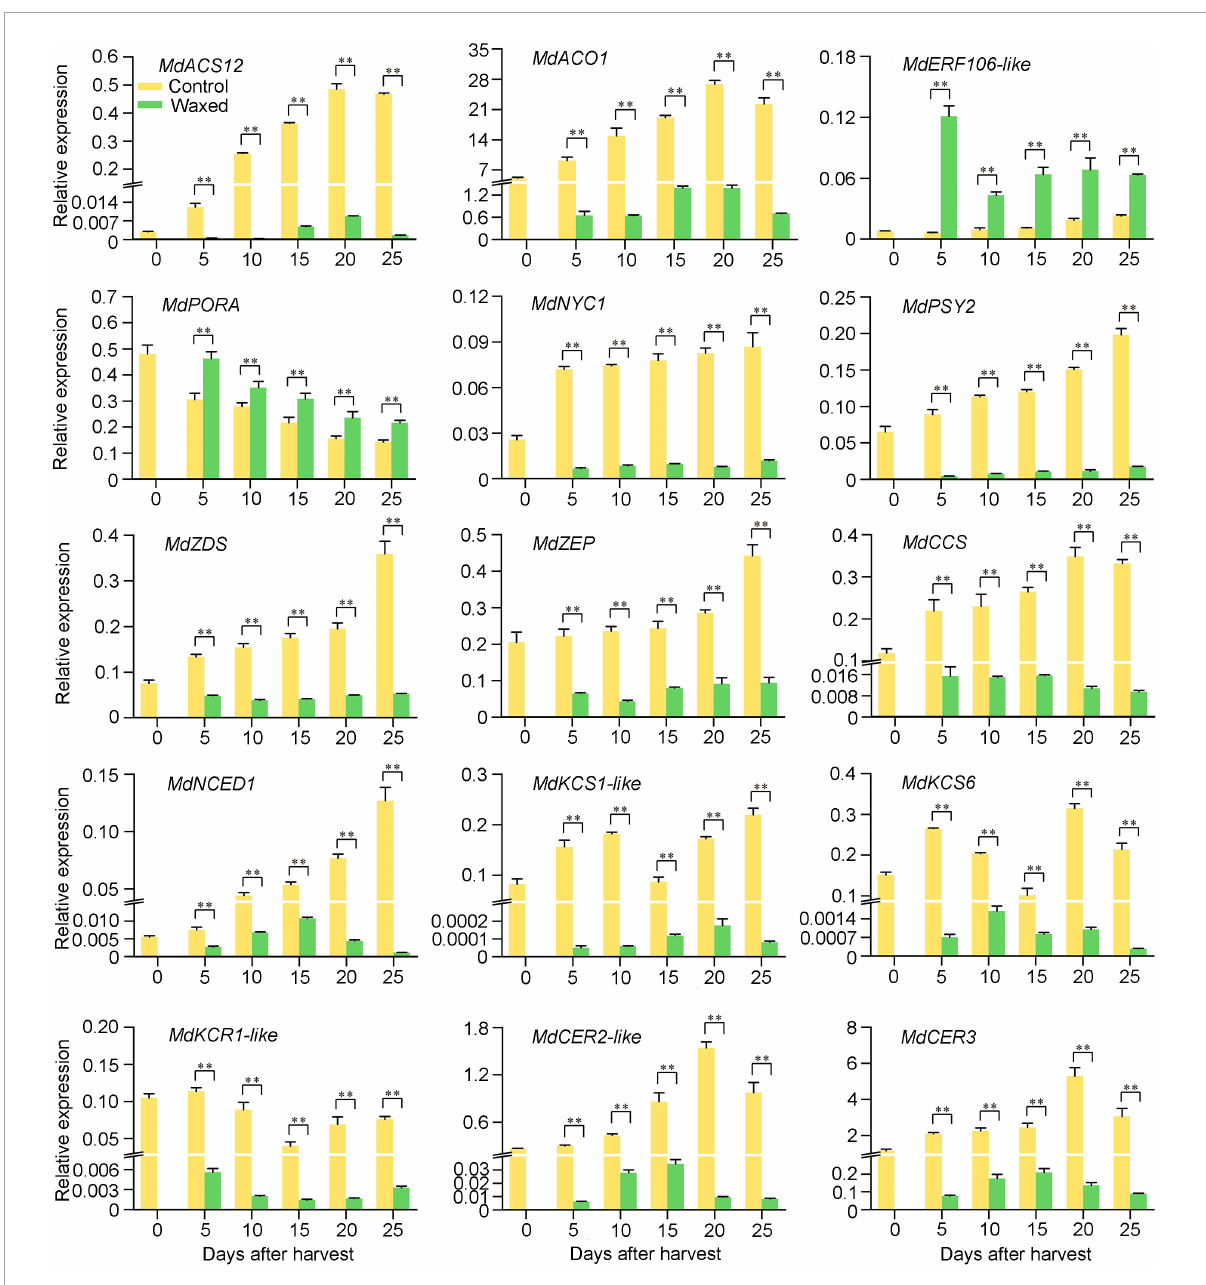
FIGURE5 qRT-PCR validation of fifteen DEGs during apple fruit storage after wax coating treatment. Control, apple fruit not receiving treatment; Waxed, fruit treated with morpholine fatty acid salt fruit wax. The x-axis represents days of storage at room temperature after harvest. For qRT-PCR, three biological replicates were analyzed. The values represent means ± SE. Statistical significance was determined using a Student’s t -test, and ∗∗ p <